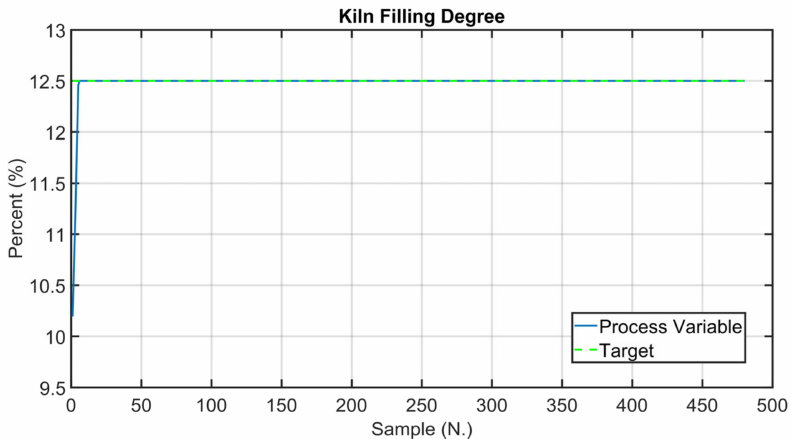
Figure 16. Rotary kiln APC system: virtual environment simulations results (kiln filling degree CV).